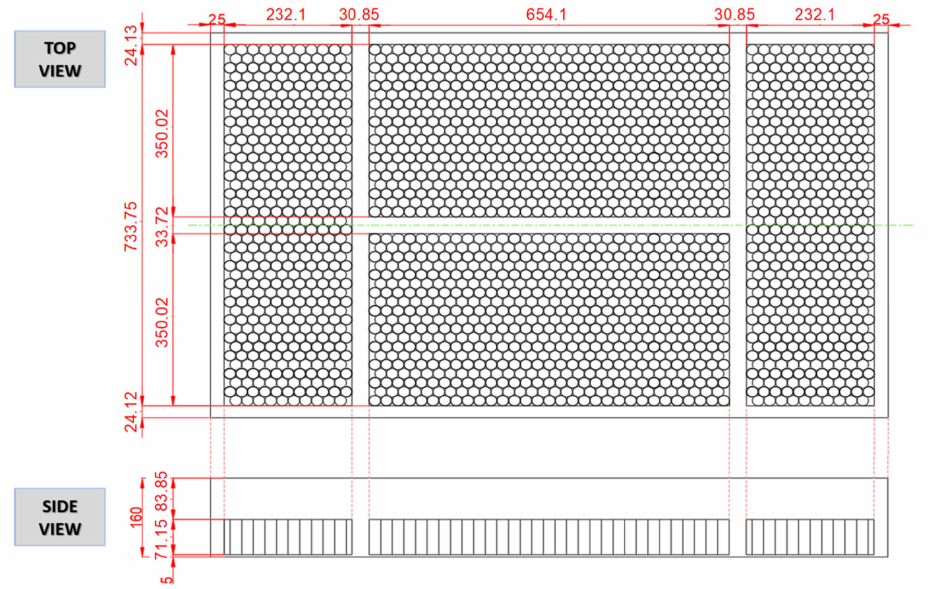
Figure 9. Pack schematic of configuration 7 with Panasonic 21700 cylindrical cells in the floor integration installation of reference